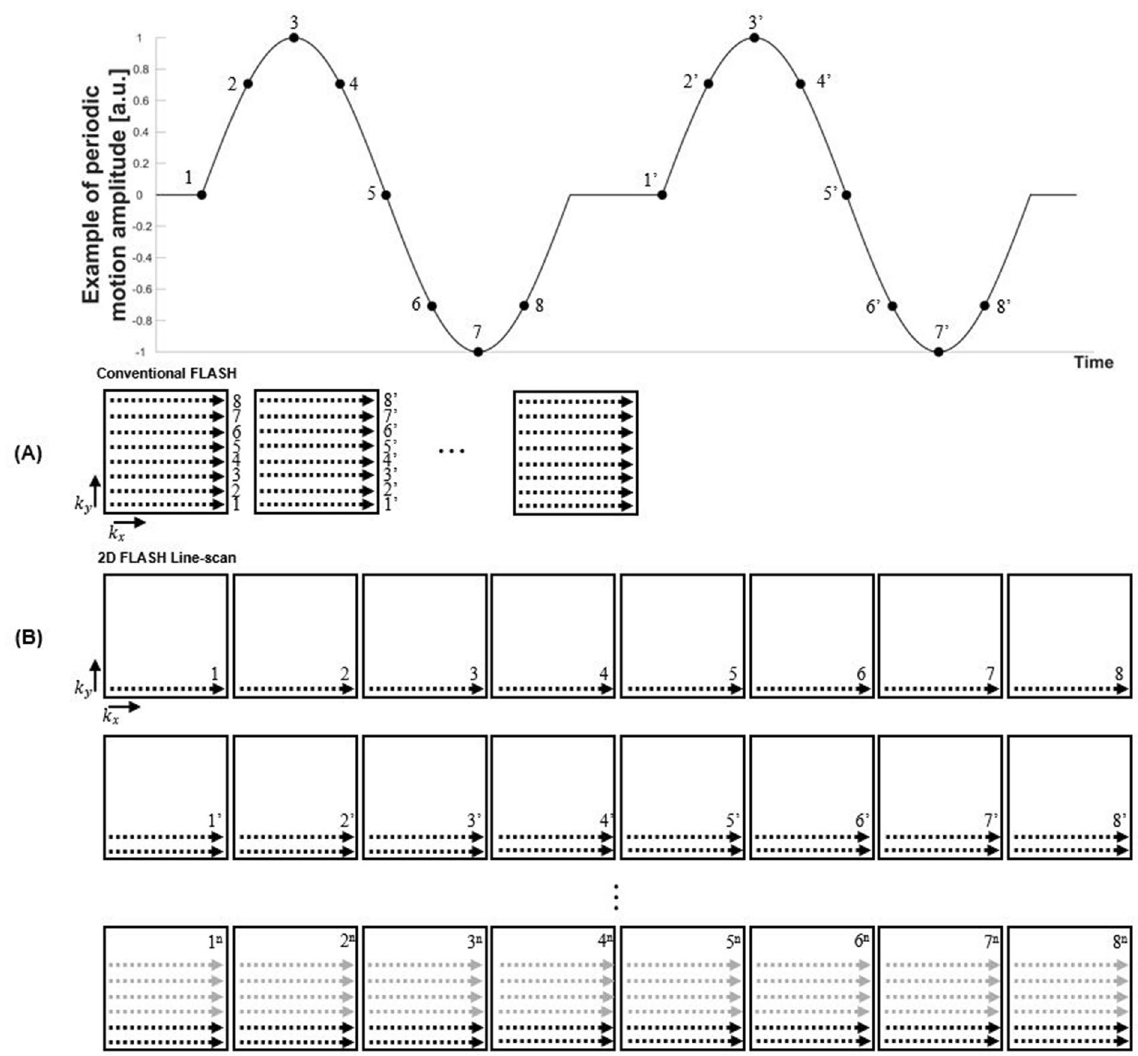
Figure 1. K-space filling scheme of a conventional spoiled gradient echo sequence ( A ) compared to the two- dimensional FLASH line-scan sequence ( B